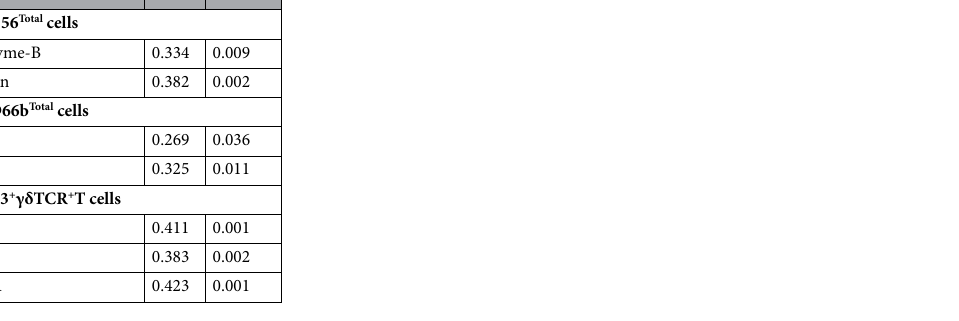
by keratometry, pachymetry and ultrastructure (e.g., polarization-sensitive optical coherence tomography) are needed to determine the functional relationships between these factors and KC pathogenesis.